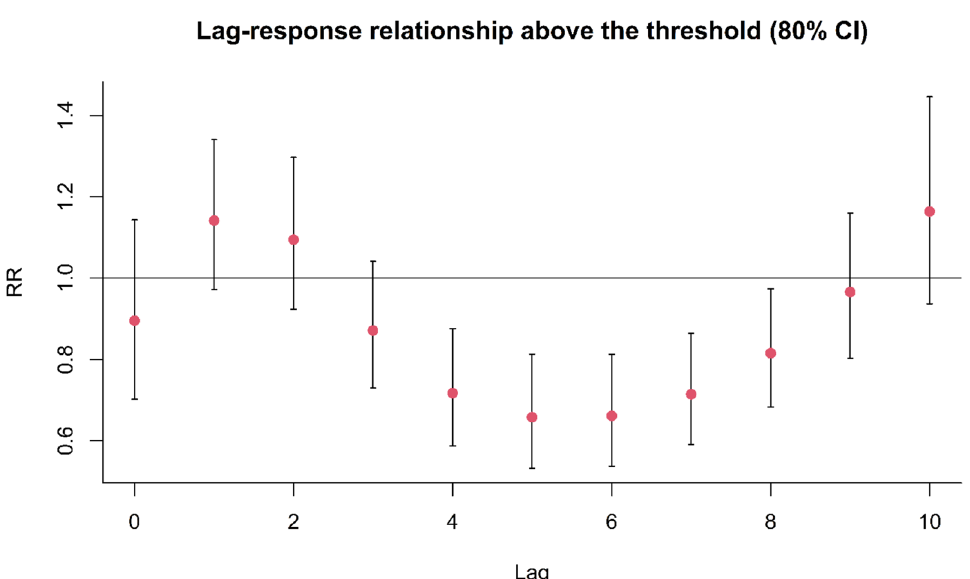
Figure 4. The association between temperature and stillbirth summarized by the RR of stillbirth associated with exposure to extreme heat temperatures (29.8 °C, the 97.5th percentile) above the optimal temperature (21 °C). The lag response curve shows the existence of the mortality displacement for extreme heat temperature. The effects of extreme heatt temperatures on stillbirth was largest at lag 1 month and then reduced below baseline from lag 3 to 8